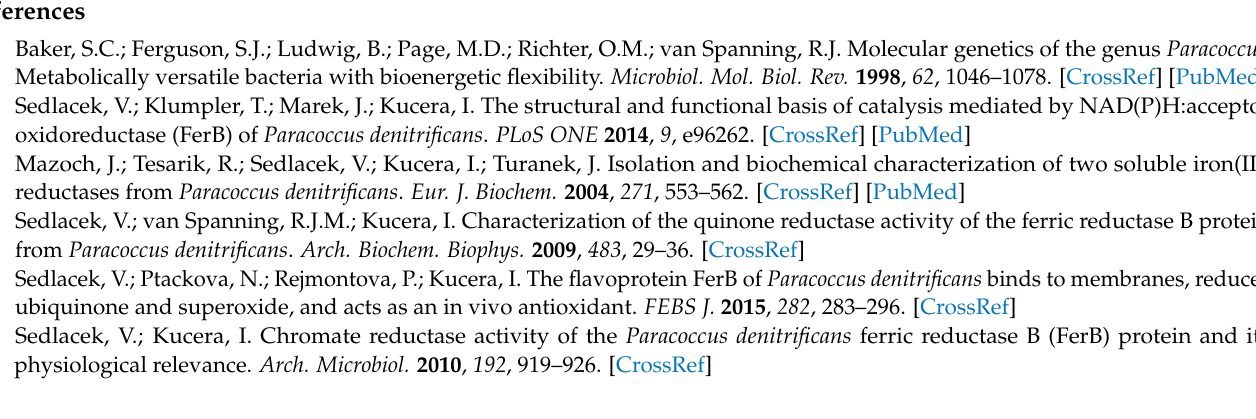
illumination; Figure S3: The crystal structure of P. denitrificans ArsH tetramer and monomer; Figure S4: Dependence of the rate of NADPH oxidation, as catalyzed by ArsH on oxygen concentration; Figure S5: Sequence alignment and a model structure of the